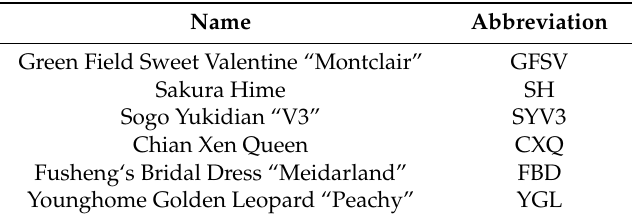
Table 1. Names and abbreviations of Phal.